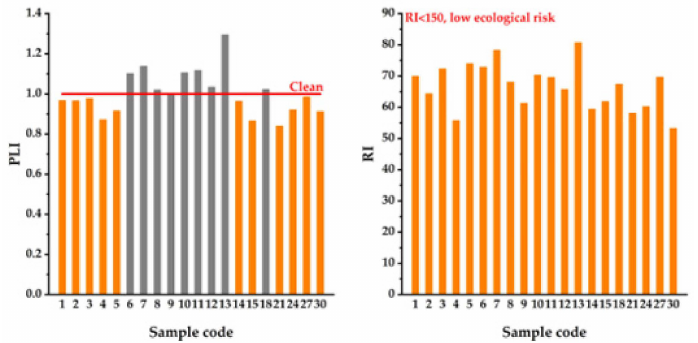
Figure 5. The results of PLI and RI evaluations from 20 surface soils for the sampling sites. The gray columns indicate nine sites in the center of Jiulongchi wetland are in a light pollution state which is in accordance with the spatial distribution of 11